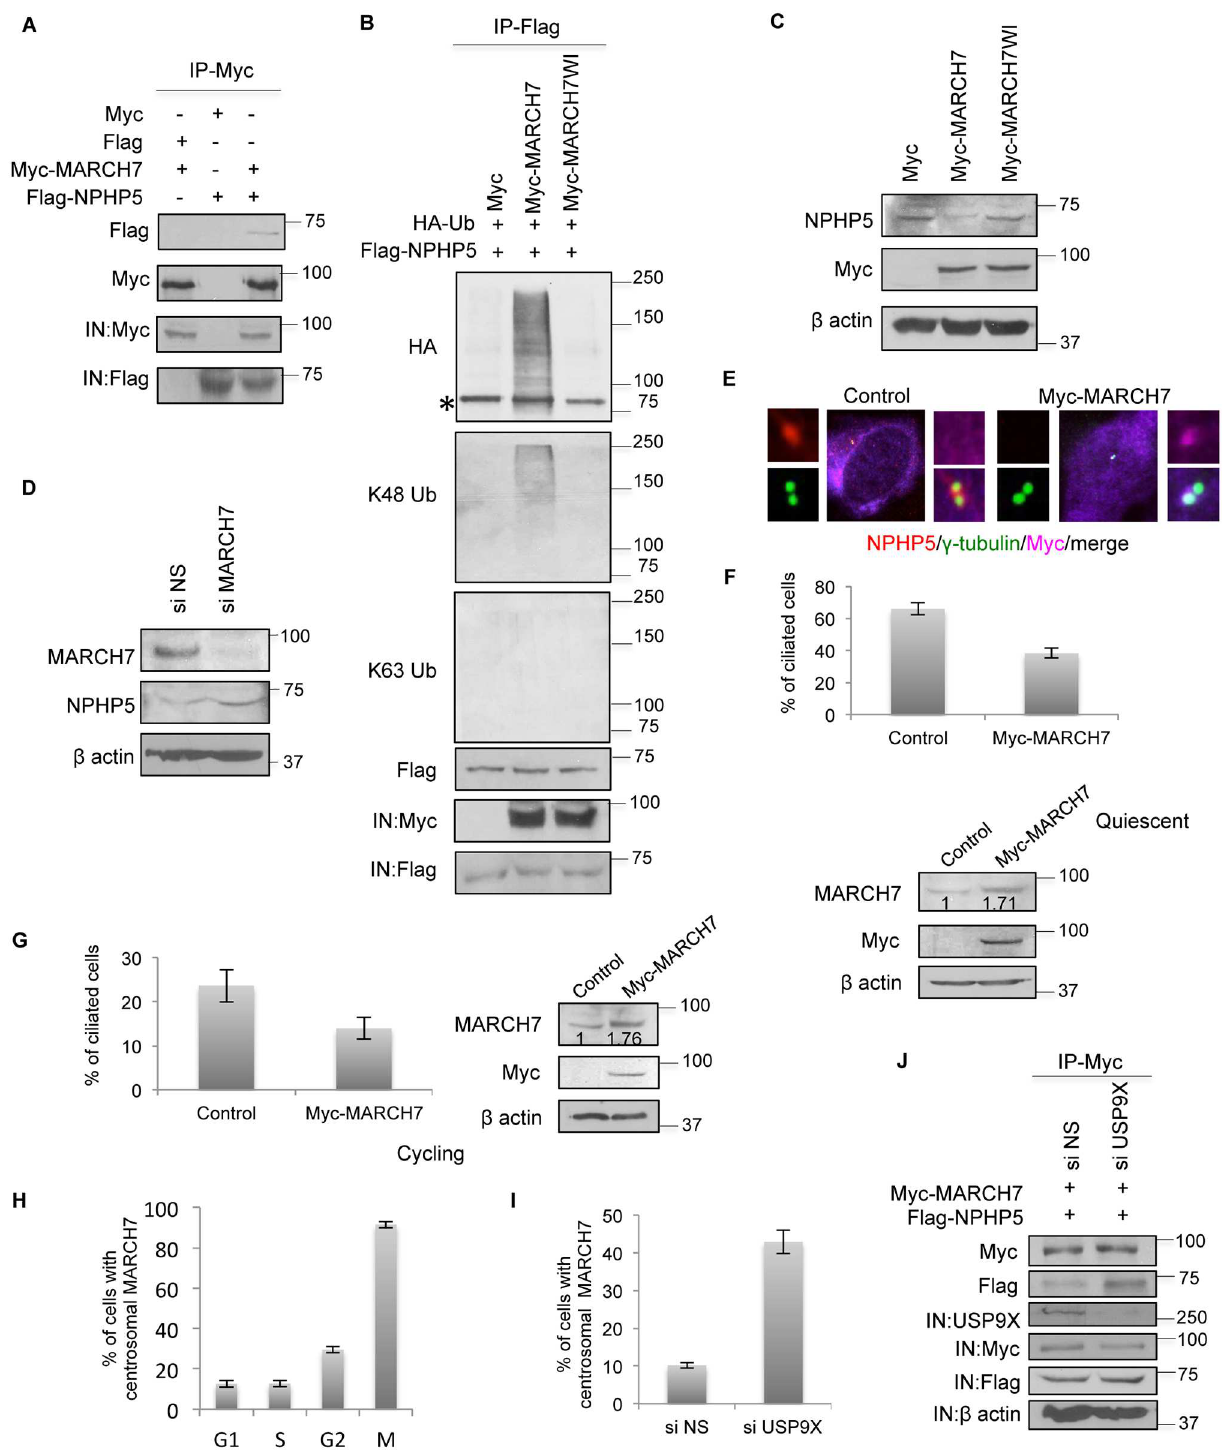
Fig 7. NPHP5 is K48 ubiquitinated by MARCH7. A) Flag or Flag-NPHP5 was co-expressed with Myc or Myc-MARCH7 in HEK293 cells. Lysates were immunoprecipitatedwith anti-Myc antibodyand Western blotted with the indicatedantibodies. IN, input. B) Myc, Myc- MARCH7 wild type or catalytically inactive mutant (WI) was co-expressed with Flag-NPHP5 and HA-Ub in HEK293 cells. Lysates were immunoprecipitatedwith anti-Flag antibody in 1% SDS and Western blotted with the indicatedantibodies. IN, input. C) HEK293 cells were transfected with Myc, Myc-MARCH7 wild type or mutant. Lysates were Western blotted with the indicatedantibodies. β actin was used as a